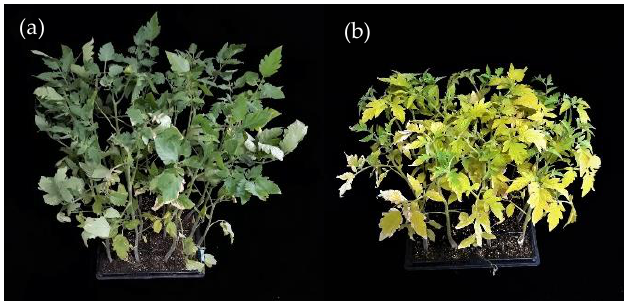
Figure 2. Differences in heat tolerance after 7 days of stress regime among seedlings of tomatoes Minichal ( a ) and Dafnis ( b ).